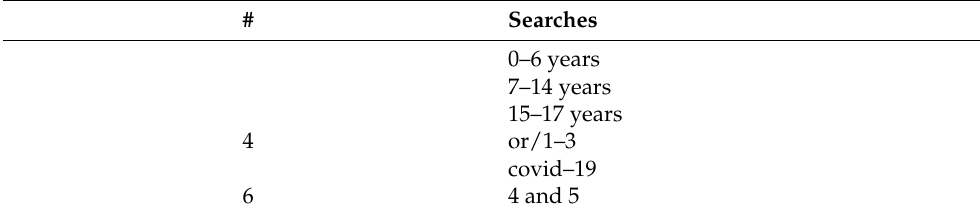
Table A9. Search